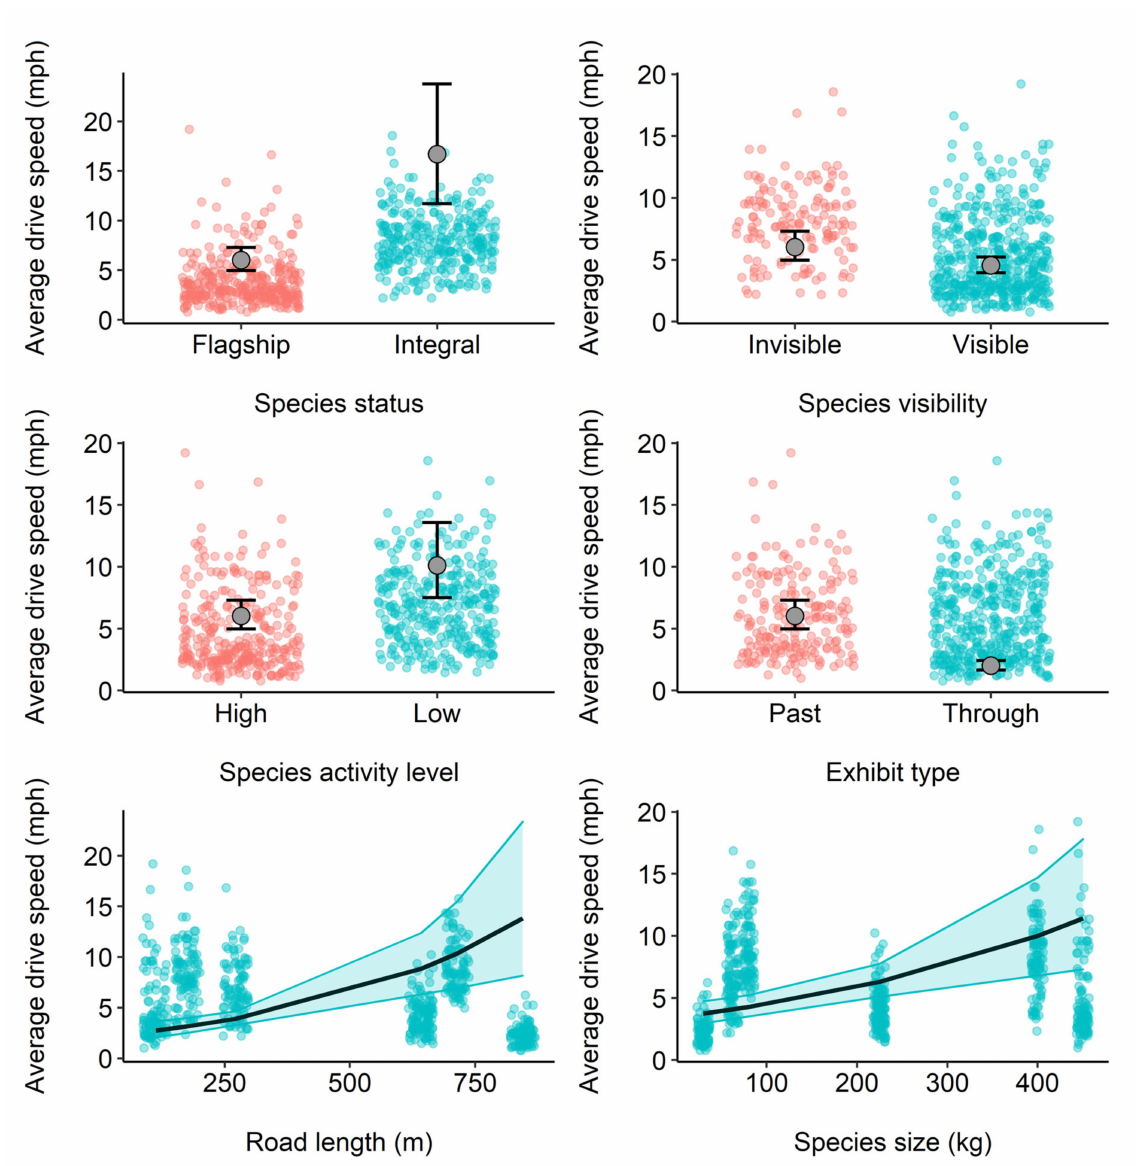
Figure 3. The effect of species traits and exhibit features on the average speed of focal vehicles